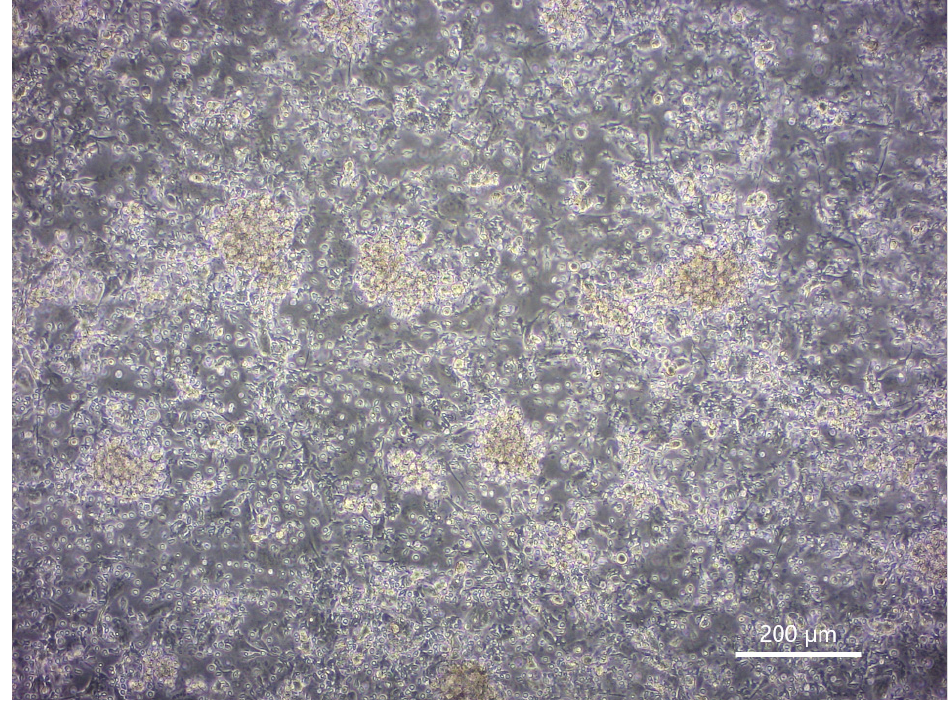
Figure 7. The CTLs induced by iPSL/DCs. The photo was taken from a 2-week co-culture of CTLs with iPSL/DCs. White bar = 200 µm.